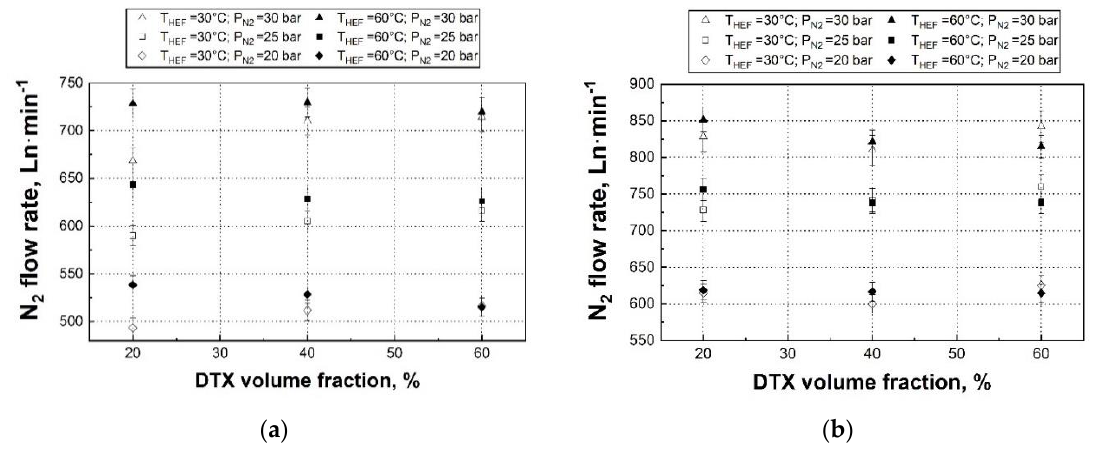
Figure 8. Comparison of normalised pressure-volume diagrams for different DTX concentrations at the engine speed of 600 rpm (corresponding to the 25 bar curve): ( a ) HEF temperature 30 °C, ( b ) HEF temperature 60 °C.